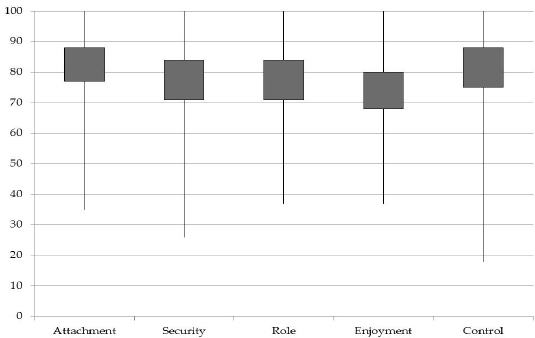
Figure 2. VAS ratings (0–100) of relevance of individual items included in ICECAP-O ( ± 1 sd and range). 0 = not important at all, 100 = could not be more important.